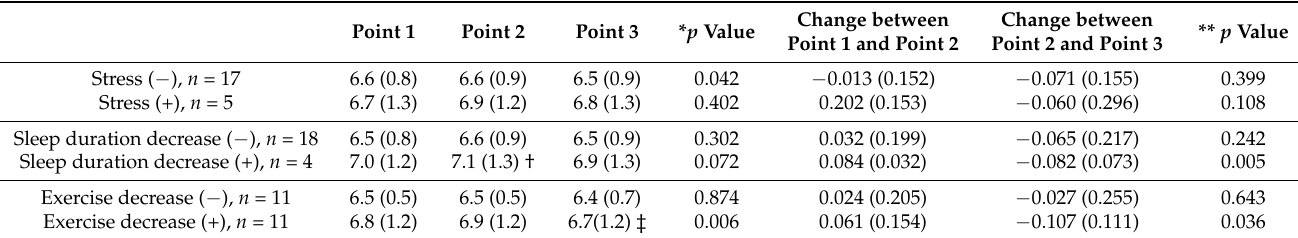
Table 5. Subgroup analysis of change of skeletal muscle mass index before and after the start of the COVID-19